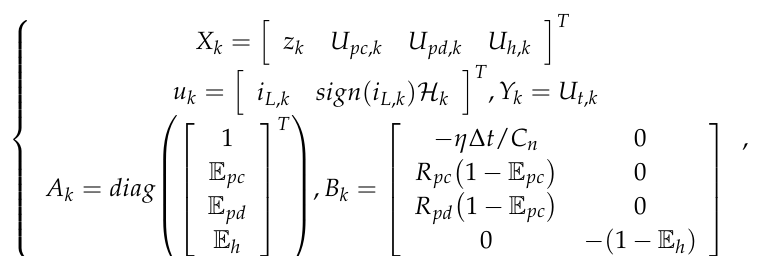
Figure 6 outlines the entire estimation framework. The ECM parameters ( (cid:2016) (cid:3013)(cid:3014)(cid:3020) ) are tuned on-line with voltage and temperature prediction errors referring to Section 4.1. Enhanced by the Peukert equation and the (cid:1847) (cid:3042)(cid:3030) ((cid:1878), (cid:1846)) correlation, an AEKF-based SoC estimator is built up to accommodate different temperatures, discharge rates, and other model uncertainties.